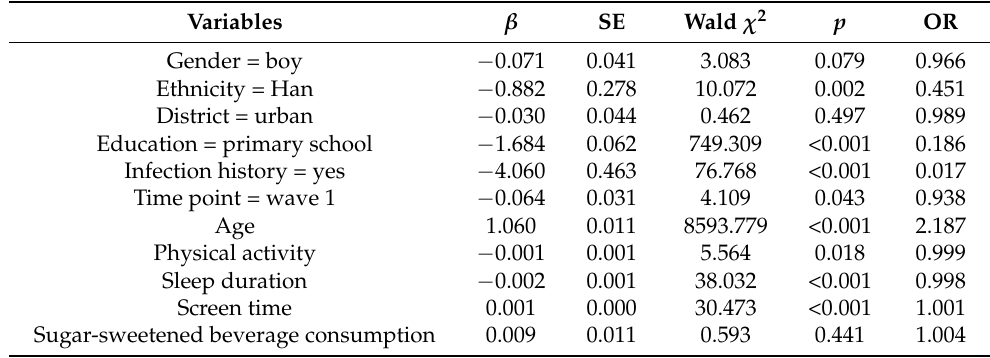
Table 4. Influencing factors of obesity in